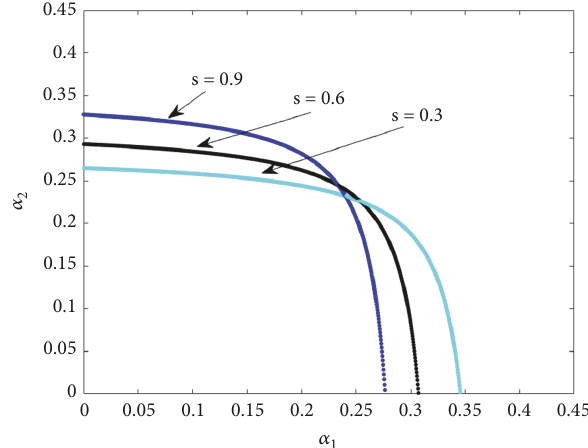
Figure 3: Attraction domain of the system.